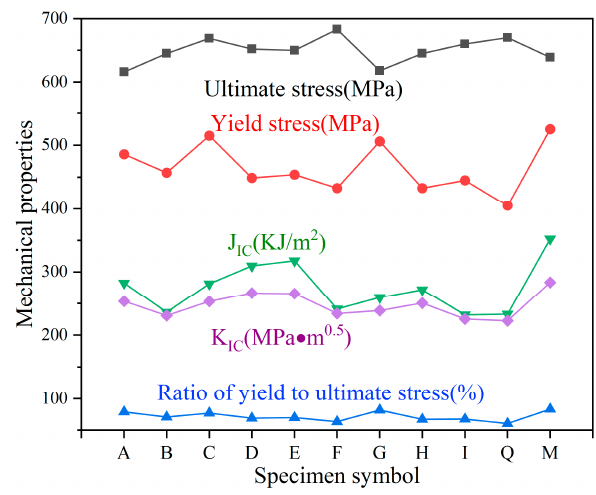
Figure 20. Mechanical properties of the welding joints with different process parameters.